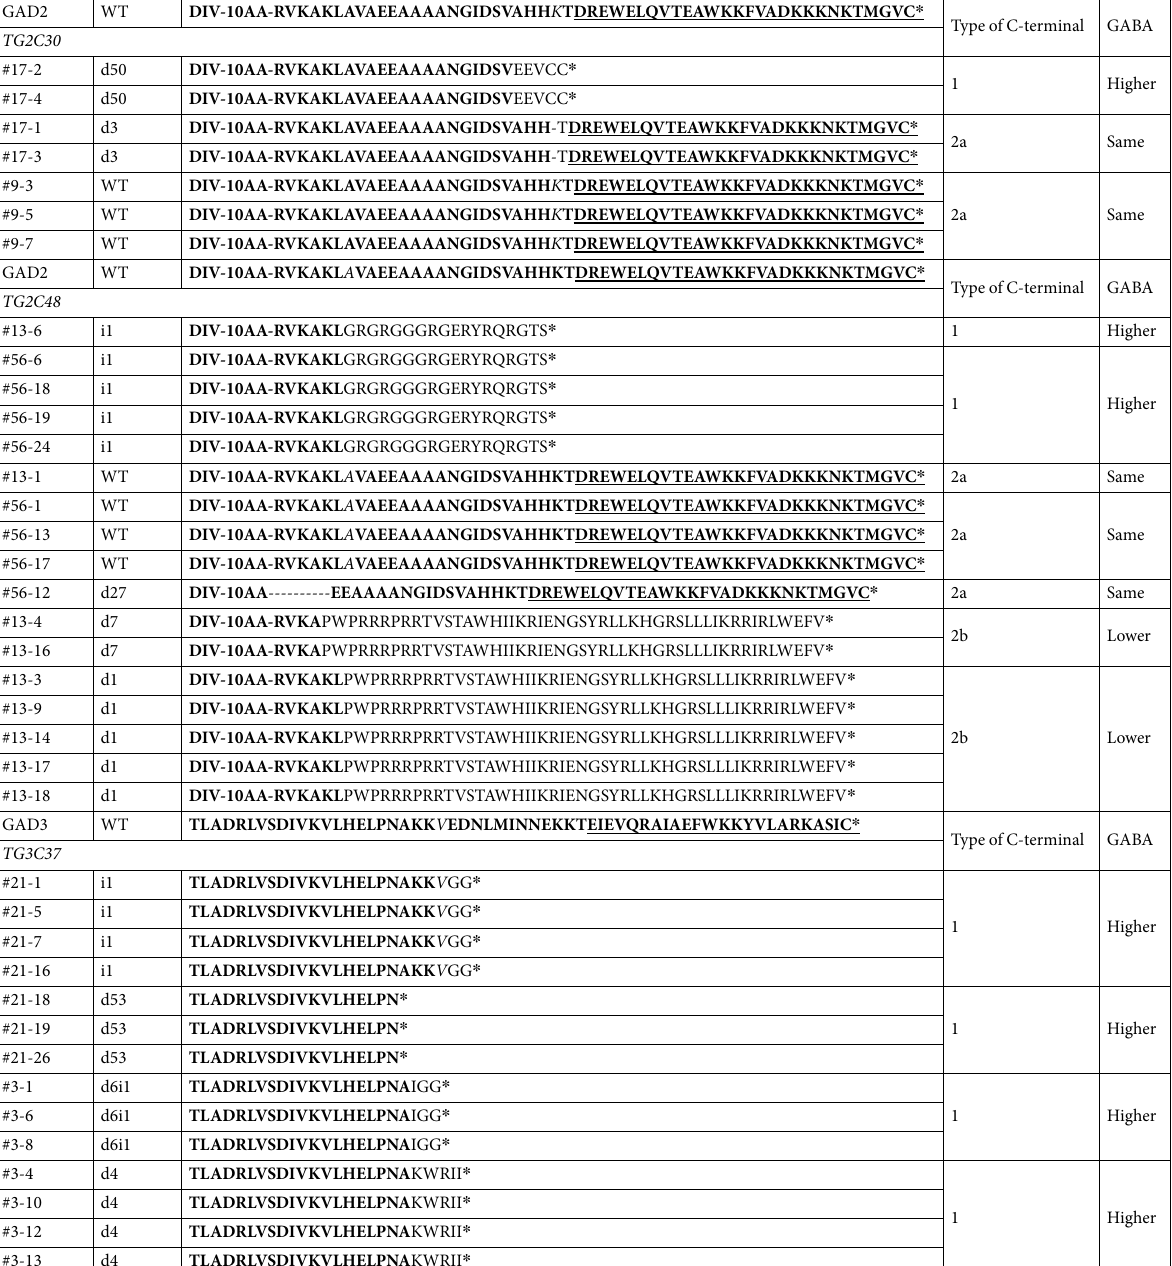
Table 3. Amino acid sequence of Target site (T1 generation). Genotype of all plants in this table were homozygous. WT, wild-type sequence with no mutation detected. “d” and “i” means deletion and insertion, respectively. “ * ” was stop codon. The same sequence as Wild Type is expressed in Bold . The changed sequence by the mutation via CRISPR/Cas9 was in Regular. Bold with underline is the putative auto inhibitory domain and CaMd domain. The target site is in Italic . “a” and “b” in Superscript mean different one base-pair deletion. “Higher” meant higher GABA content comparing with WT. “Lower” shows lower GABA content than WT. “Same level” indicated almost the same contain level as WT. GABA content was measured by HPLC, using leaf (TG3C30 and TG2C48) and fruits at the Br + 10 stage (red)